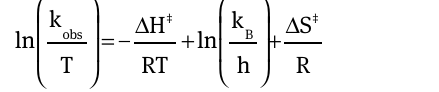
and 0.1 M TBAB at 6 bar p (CO 2 2